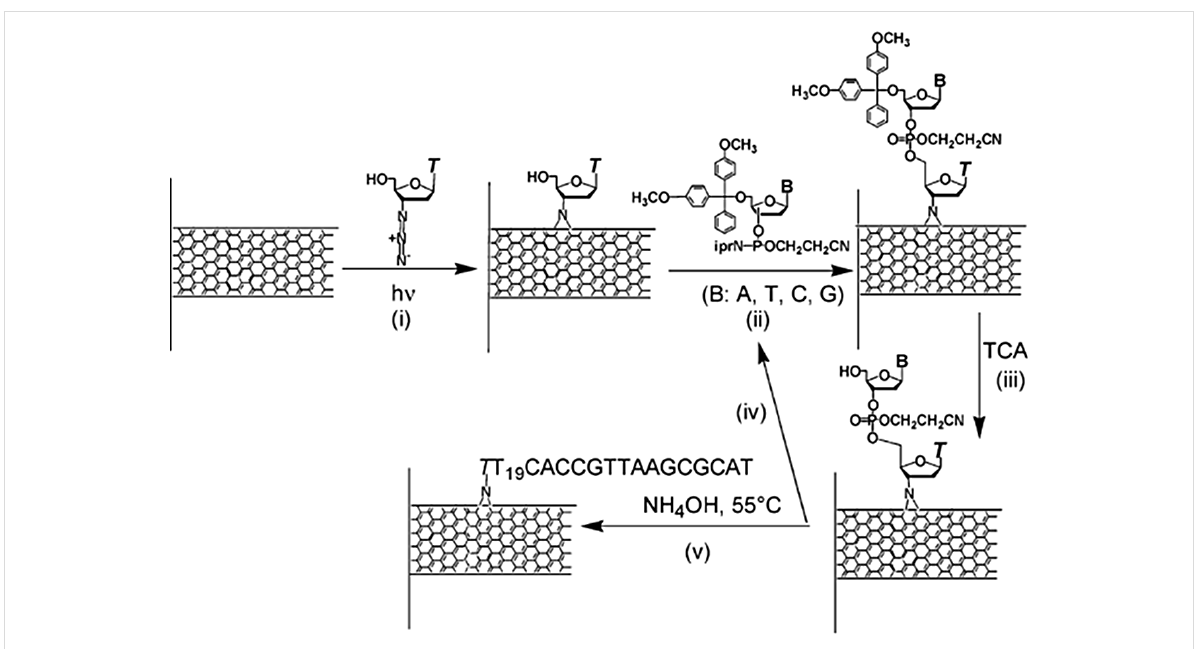
Figure 22: In-situ DNA synthesis from sidewalls of carbon nanotubes photoetched with azidothymidine. Aligned MWCNTs on a solid support are coated with a solution of azidothymidine and are UV irradiated to produce photoadducts, each with a hydroxyl group (i). The hydroxyl group reacts with a phosphoramidite mononucleotide to initiate synthesis of the DNA molecule (ii). Trichloroacetic acid deprotects the hydroxyl group (iii) for reac- tion with the next nucleotide (iv) and the cycle is repeated until the molecule with the desired base-sequence is made. Finally, the supported nanotubes are heated in ammonia solution to remove blocking groups from the nucleotides (v) to produce DNA-coated nanotubes. Adapted with permission from [164]. Copyright 2004 American Chemical